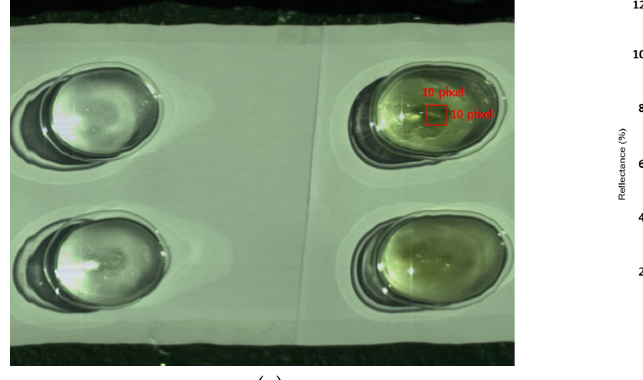
Figure 6. Hyperspectral image extraction method (( a ) region of interest—pixel range se tt ing; ( b ) hyperspectral system—100 spectra for each pixel).